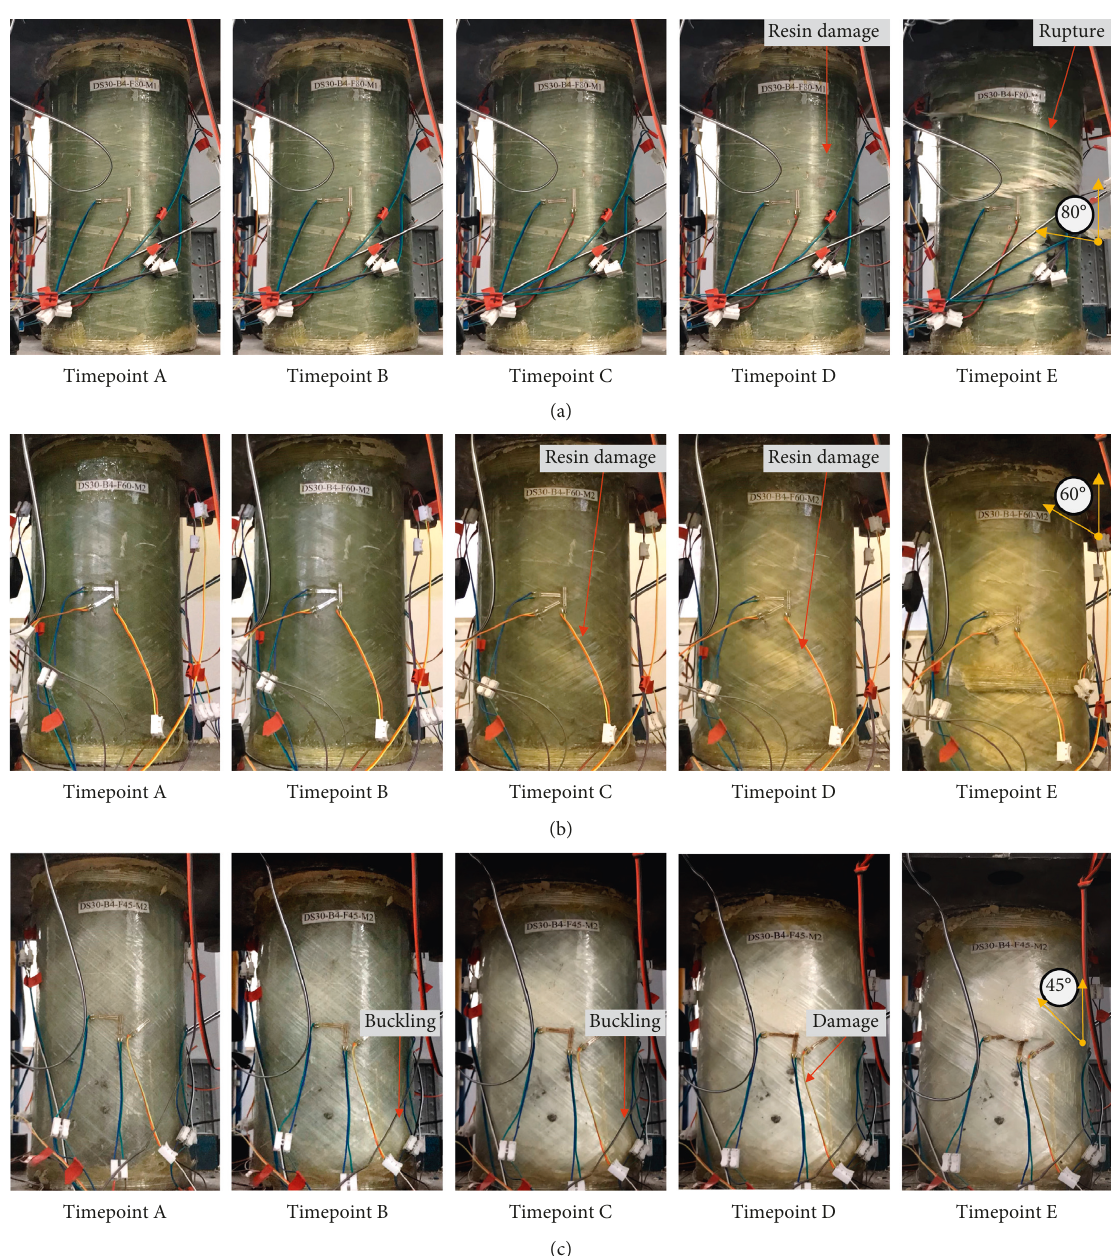
Figure 11: Damage processes of typical specimens. (a) B4-F80-M1 ( θ � ± 80 ° ; t t � 4mm; Type B steel tube). (c) B4-F45-M2 ( θ � ± 45 ° ; t frp